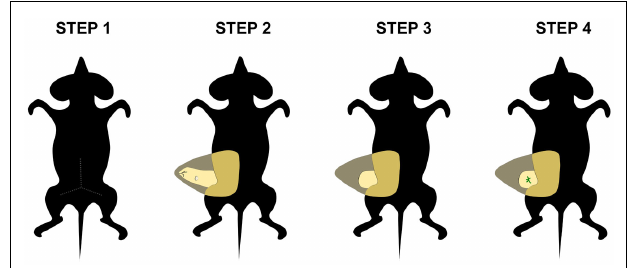
FIGURE 3 |Transplantation into postnatal mammary fat pad. This in vivo tissue recombination assay can be used to assess the effect of the adult mammary mesenchyme in the fate determination of stem cells. First, an incision is made in the abdominal skin of the host mouse (step 1) and the skin is pulled away from peritoneal wall to expose the mammary fat pad (step 2). Subsequently, the fat pad tissue from the lymph node to the nipple area is removed (step 3). Finally, donor tissue is transplanted into the cleared fat pad (step 4).